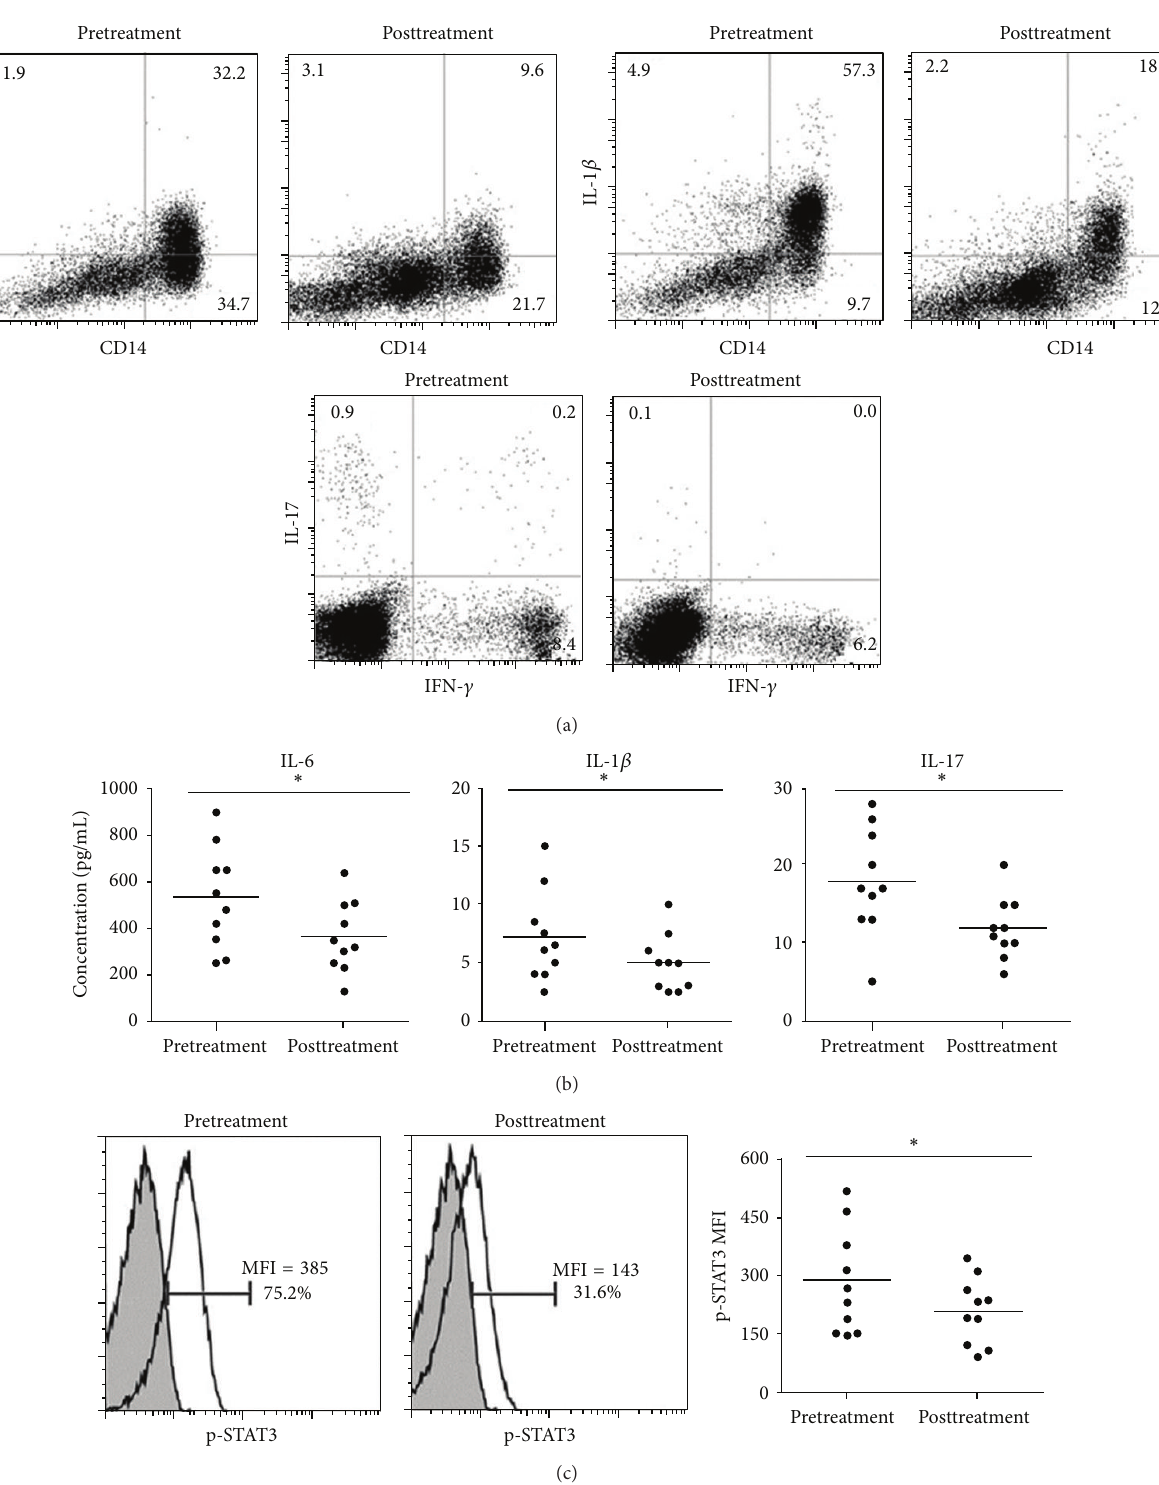
Figure 5: Decreased Th17 cell differentiation after anti-TNF 𝛼 treatment in RA patients. A group of RA patients ( 𝑛 = 10 ) were treated with infliximab. Blood specimens were obtained at baseline or 22 weeks after treatment. (a) The percentage of Th1 and Th17 cells in CD4 + T cells and that of IL-6 and IL-1 𝛽 producing cells in CD14 + cells were determined by flow cytometry. (b) The concentration of IL-6, IL-1 𝛽 , and IL-17 in sera from the pretreatment or posttreatment of RA patients. (c) The phosphorylation of STAT3 in CD4 + T cells from the same specimens was analyzed by flow cytometry. The open or shaded areas represent p-STAT3 antibody staining or isotype control, respectively. The shown data are representative of ten paired PBMC specimens (left panel). MFI: mean fluorescent intensity. Line represents mean MFI values (right panel). In all cases, asterisks indicate statistically significant differences between the two groups ( ∗ 𝑃 < 0.05